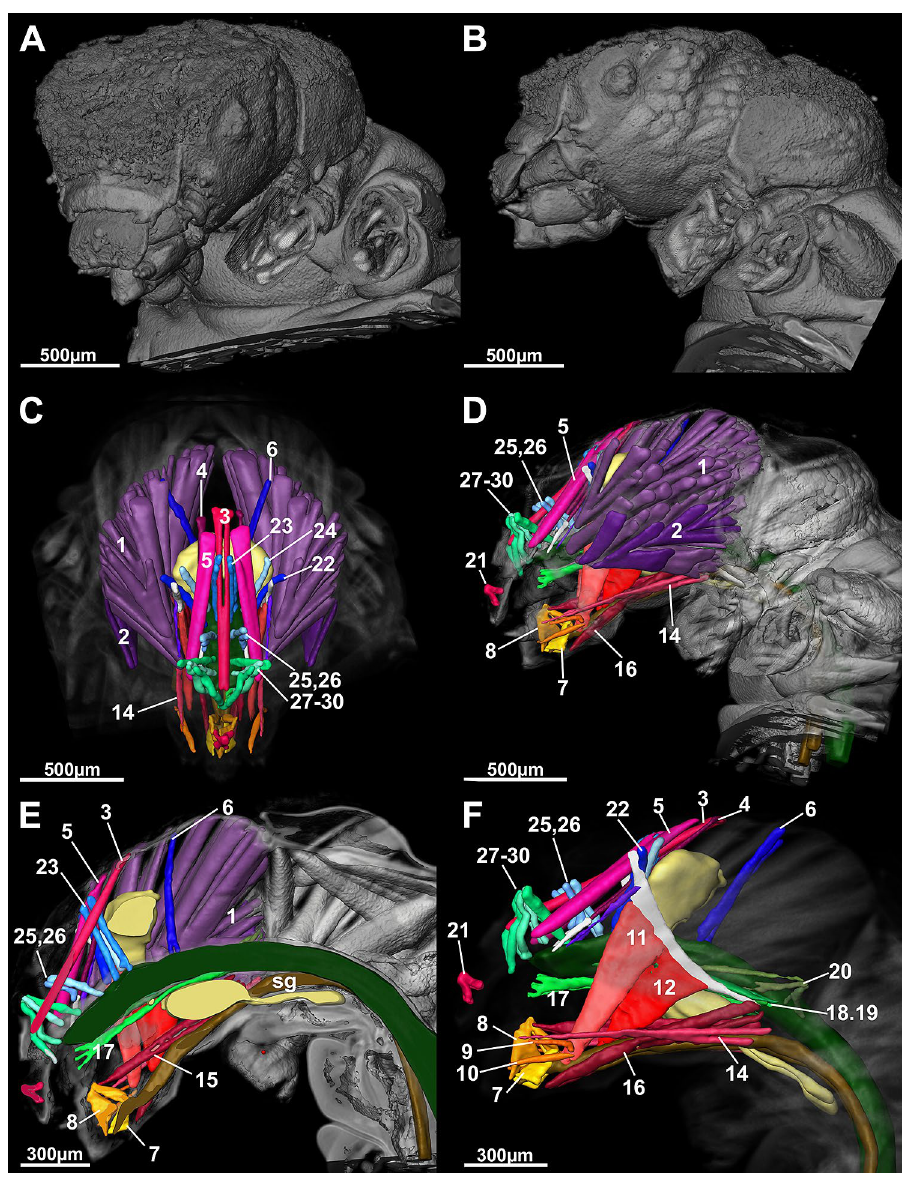
Figure 4. 3D-reconstruction of the morphology ( A left fronto-lateral view, B lateral view) and the internal head anatomy ( C frontal view, D lateral view, E sagittal view, F Hagenparasagittal plane at the level of the tentorium) of Drusus discolor (5th larval instar) based on µCT data. Abbreviations: 1 = Musculus (M.) cranio-mandibularis medialis, 2 = M. cranio-mandibularis lateralis, 3 = M. fronto-labralis, 4 = M. fronto-pharyngalis, 5 = M. fronto- epipharyngalis, 6 = M. cranio-postpharyngalis dorsalis, 7 = M. praemento-salivaris, 8 = M. hypopharyngo- salivarialis, 9. = M. basistipito-dististipitalis lateralis, 10 = M. basistipito-dististipitalis medialis, 11 = M. tentorio- stipitalis, 12 = M. tentorio-cardinalis, 14 = M. cranio-dististipitalis, 15 = M. cranio-praementalis medialis, 16 = M. cranio-praementalis lateralis, 17 = M. cranio-cibarialis, 18 = M. cranio-pharyngalis anterior, 19 = M. cranio- pharyngalis posterior, 20 = M. cranio-postpharyngalis ventralis, 21 = M. labro-epipharyngalis, 22 = M. cranio- pharyngalis lateralis, 23 = M. fronto-pharyngalis medialis, 24 = M. fronto-pharyngalis lateralis, 25 and 26 = M. fronto-pharyngalis ventralis, 27 and 28 = M. clypeo-pharyngalis, 29 and 30 = M. clypeo-cibarialis, te = tentorium. The figure was built using the visualization software Amira 2020.2 (Thermo Fisher Scientific, https:// www. therm ofish er.